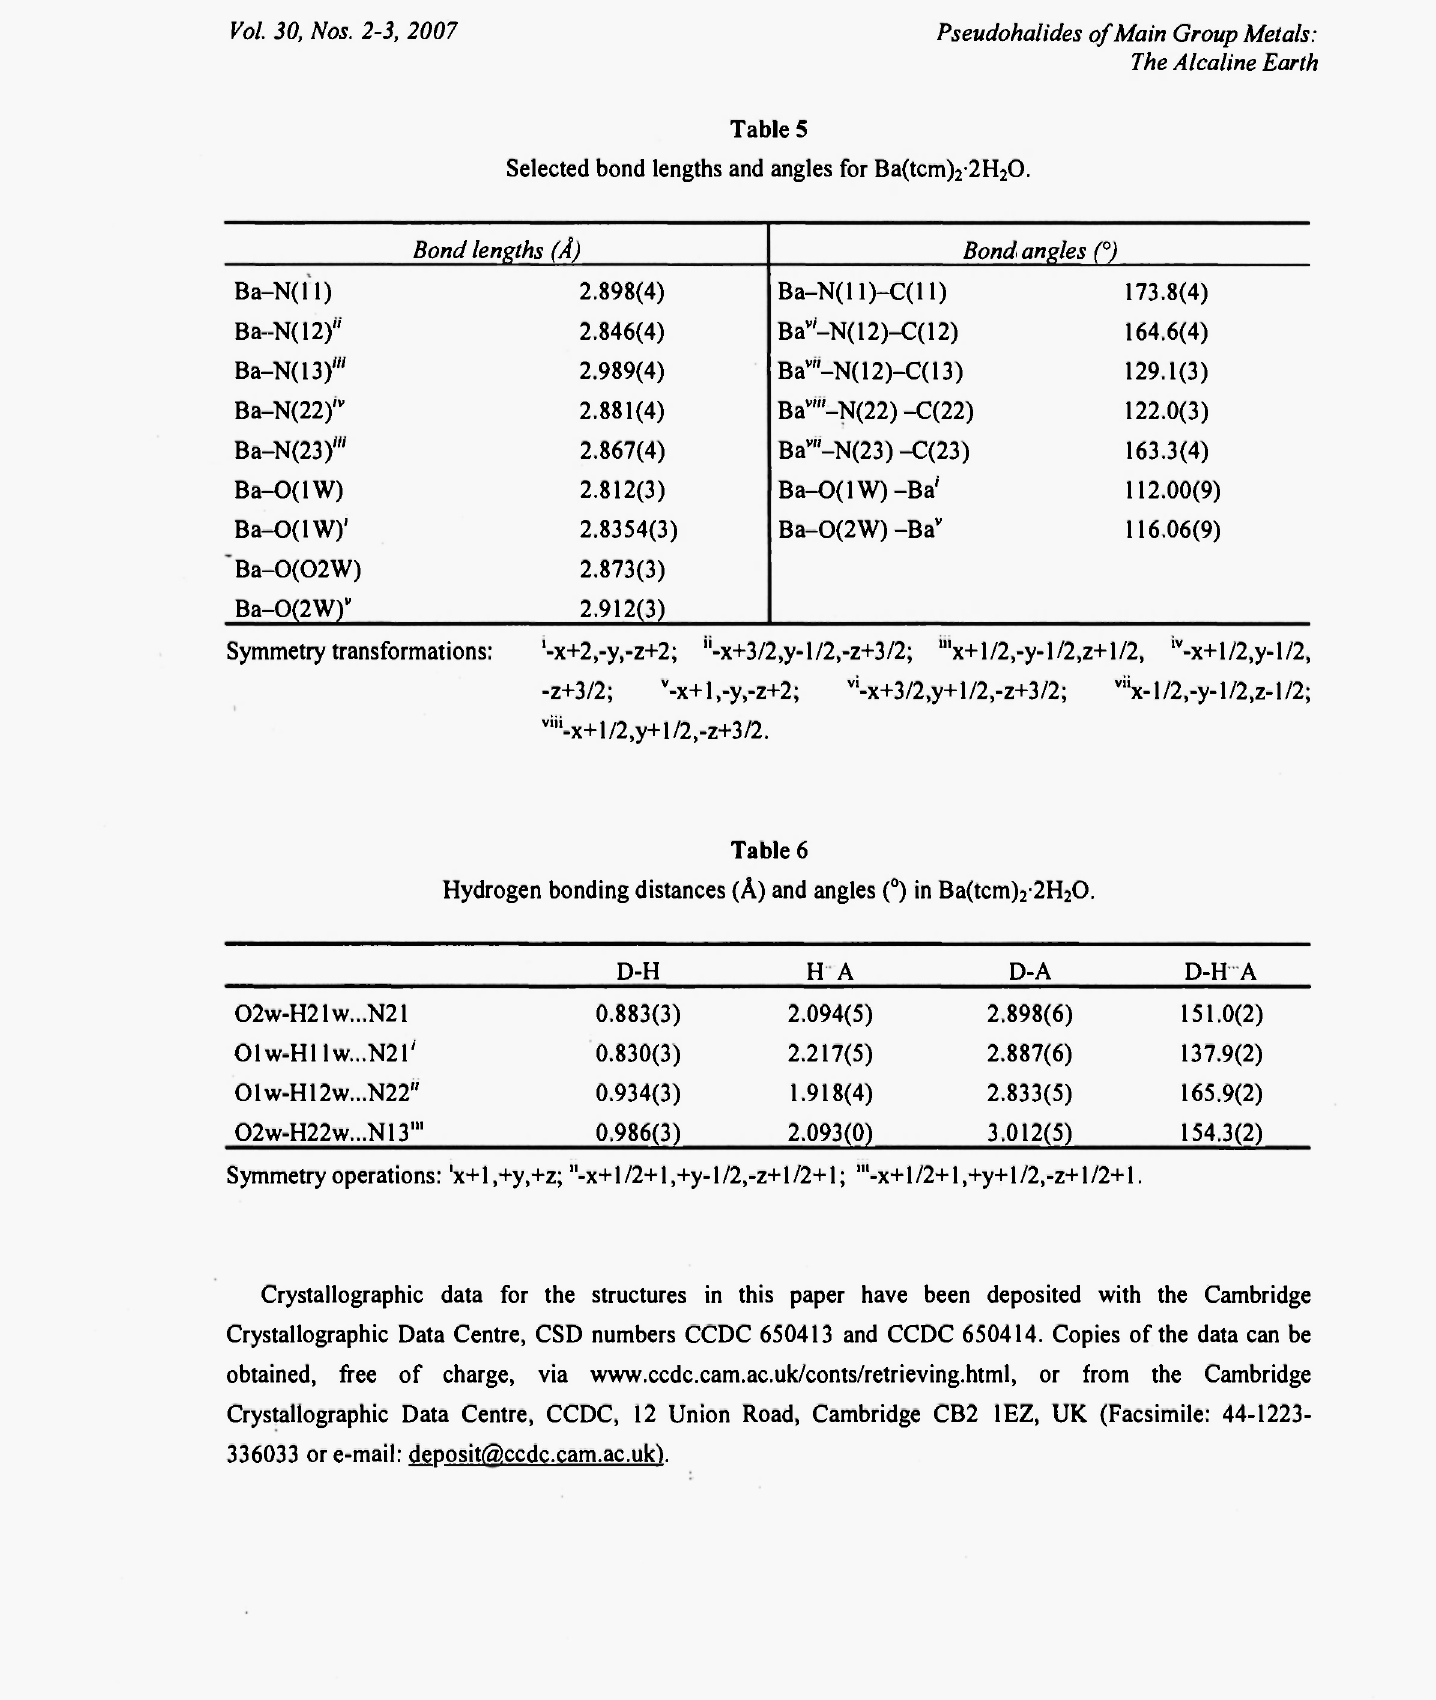
Selected bond lengths and angles for Ba(tcm) 2 -2H 2